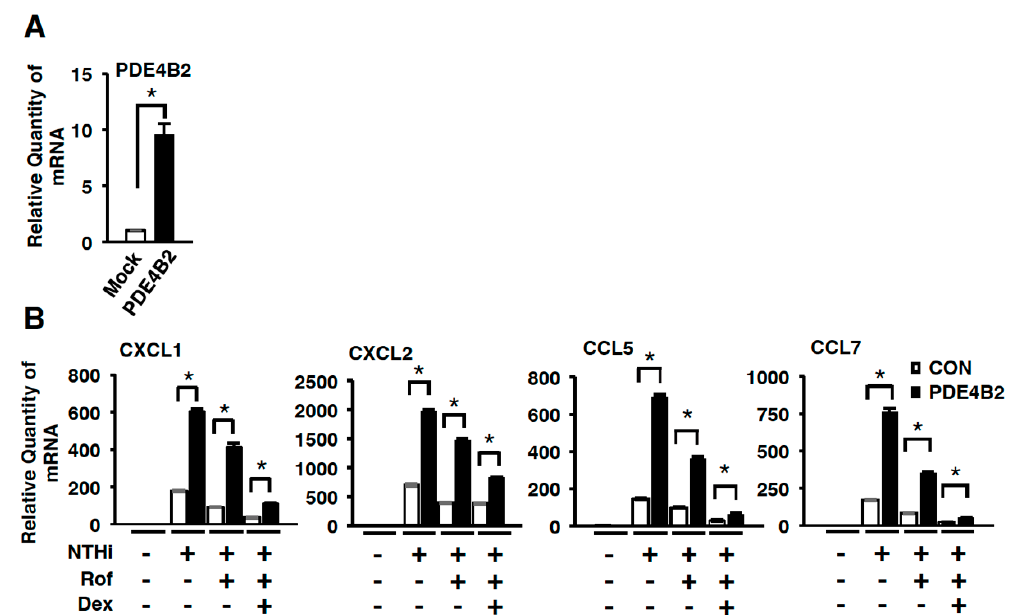
Figure 3. Dexamethasone improves the anti-inflammatory effect of roflumilast in cells stably expressing PDE4B. ( A ) PDE4B expression in mock and PDE4B2-stable cells. Data are mean ± S.D. ( n = 3); * p < 0.05. ( B ) Mock or PDE4B2 stable cells were pre-treated with Rof (10 µM) or Dex (100 nM) for 1 h followed by 5 h stimulation with NTHi, and mRNA expression of pro-inflammatory mediators was analyzed by Q-PCR. The relative quantity of mRNA is relative to a house keeping gene cyclophilin . Data are mean ± SD ( n = 3); * p < 0.05. Data are representative of three independent experiments.